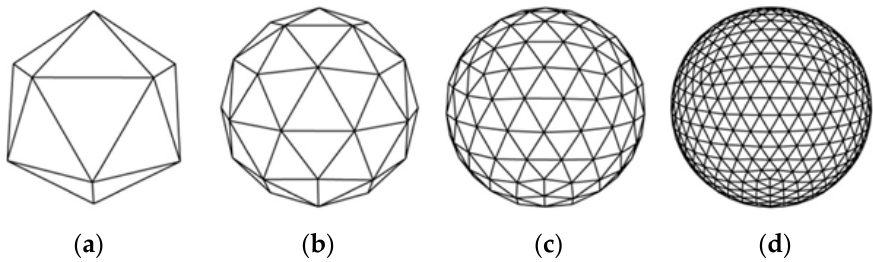
printed object, but also the bigger the size of the file. The influence of the linear tolerance is shown in Figure 1 [3].